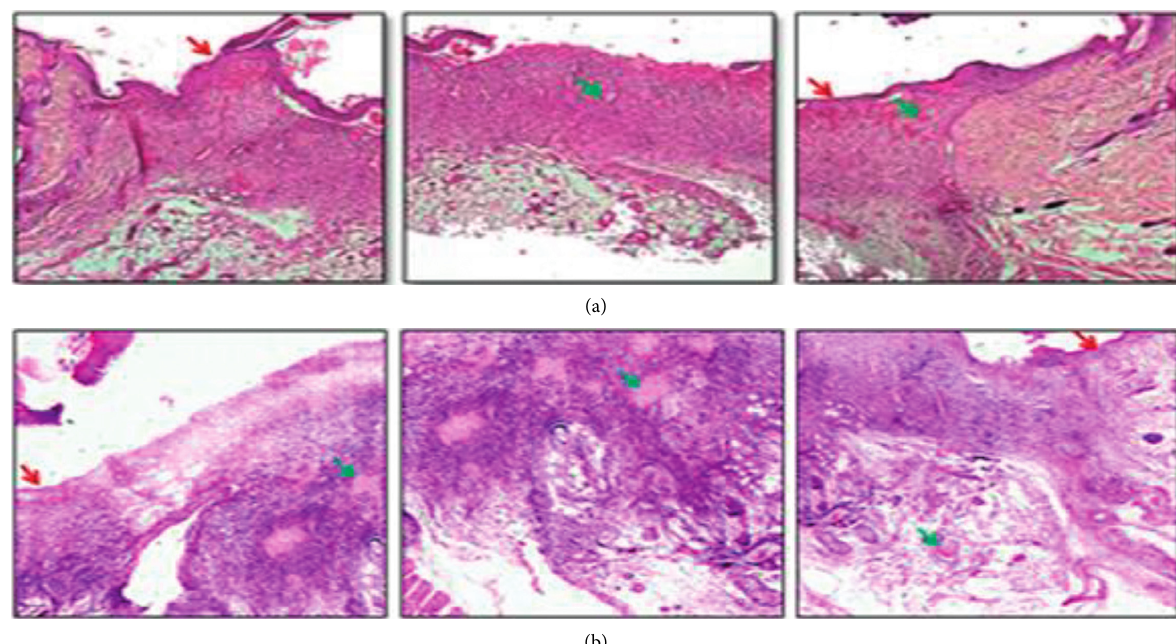
Figure 11: (a). Control (untreated) and (b) test (dHAM+TSP gel+ coconut fiber): photomicrographs of H and E-stained images showing the wound edges and wound crater. Epithelialization is marked by a red arrow and collagen formation by green